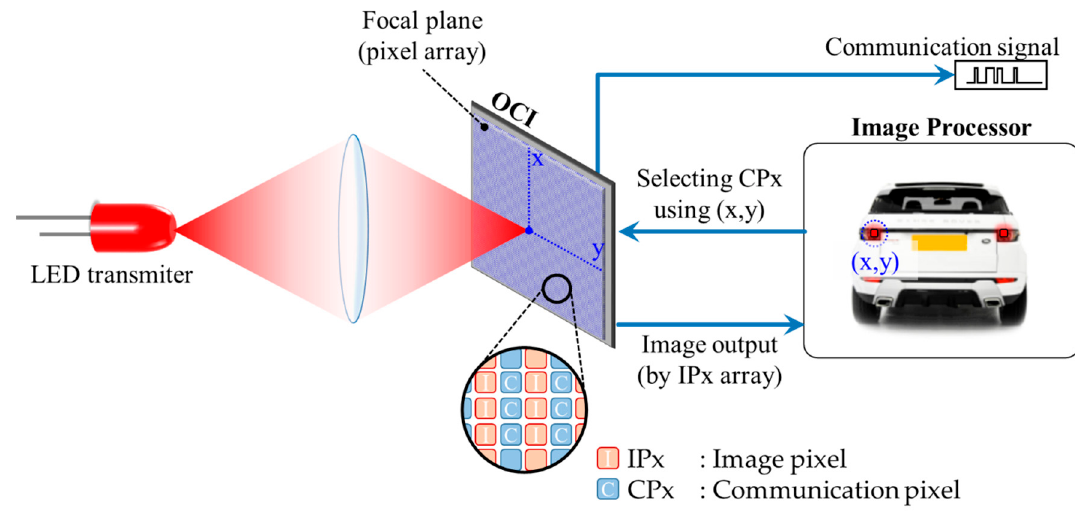
Figure 19. Basic operation of IS-OWC system.